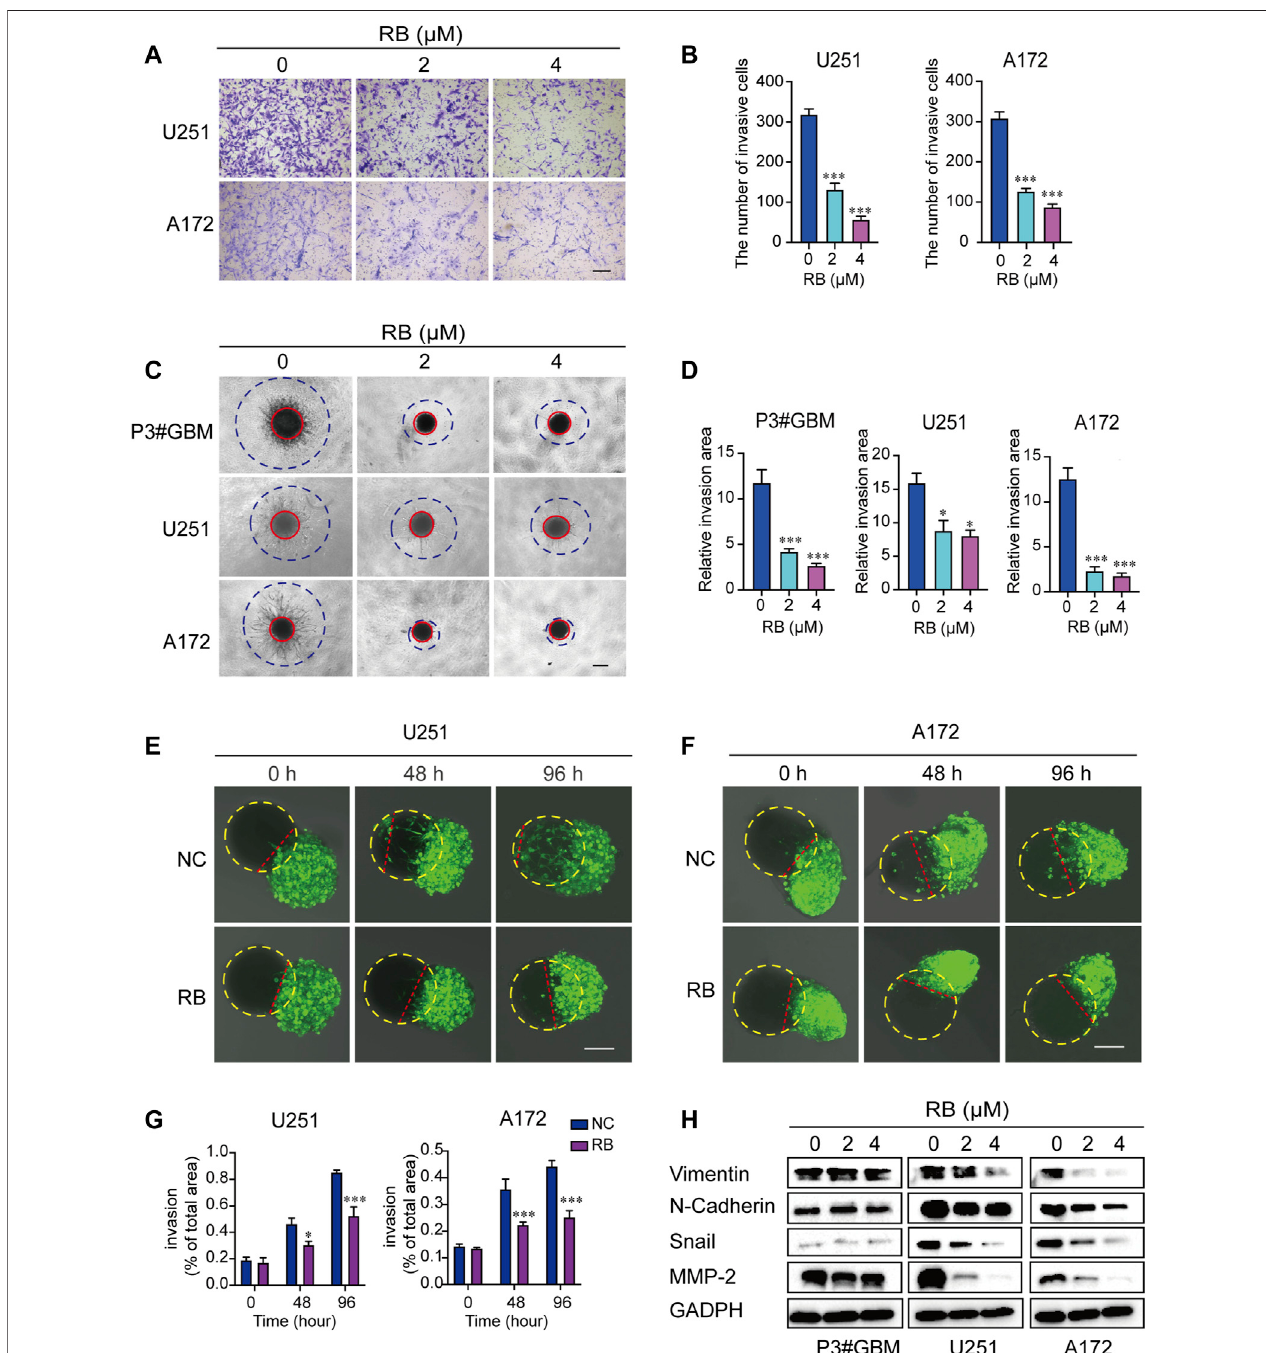
FIGURE 2 | RB inhibits the invasion of GBM cells. (A) Representative images of transwell invasion assays. Scale bar, 100 μ m. (B) The numbers of invasive GBM cellsshownin (A) . (C) Representativeimagesofthe3DspheroidinvasionassayperformedonP3#GBM,U251andA172cellstreatedwithvehiclecontrol(dilutedDMSO) or RB (2 or 4 μ M) and evaluated on the 6 th day. Scale bar, 200 μ m. (D) Graphic representation of the relative invasive area shown in (C) . (E) Representative images of coculture invasion assays for U251 cells treated with vehicle, DMSO (0) and 4 μ M RB and evaluated at 0, 48, and 96 h. The yellow dotted line represents brain organoids, and the red dotted line represents the U251 cell invasion range. Scale bar, 100 μ m. (F) Representative images of coculture invasion assays for A172 cells treated with vehicle, DMSO (0) and 4 μ M RB and evaluated at 0, 48, and 96 h. The yellow dotted line represents brain organoids, and the red dotted line represents the A172cellinvasionrange.Scalebar,100 μ m. (G) Quanti fi cationoftheinvasiveareaafter0,48,and96 hof4 μ MRBtreatmentshownin (E,F) . (H) Westernblotanalysisof MMP2 and EMT-related proteins after 4 μ M RB treatment for 48 h. Three independent experiments were performed with data shown as the mean ± SEM by two-way ANOVA (G) or one-way ANOVA (B,D) . * p < 0.05; ** p < 0.01, and *** p <